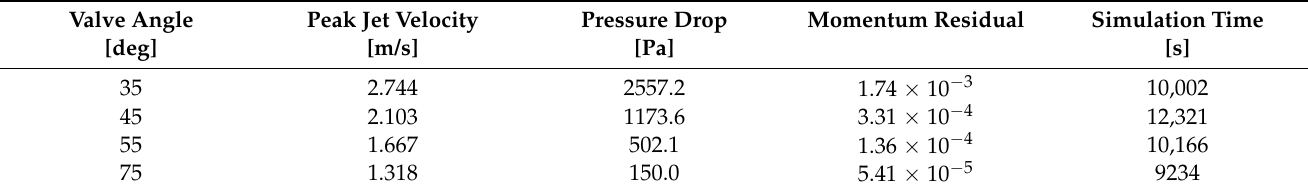
Table 7. Simulation Cases: PINN.